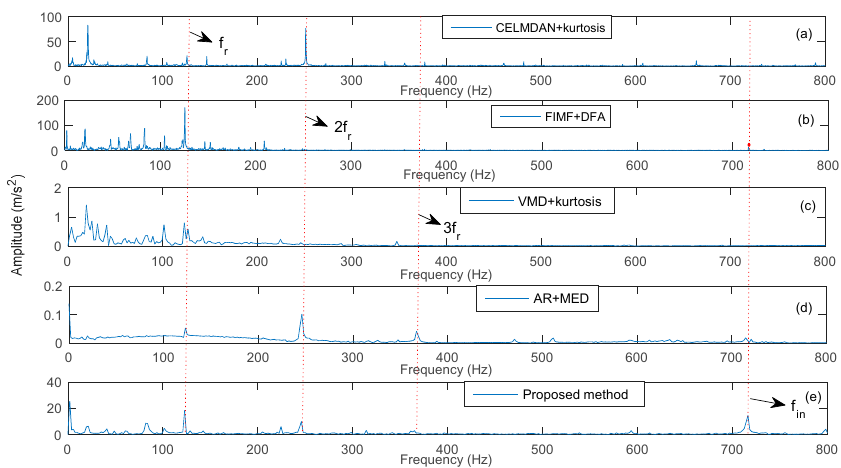
Figure 31. Identified fault frequency of a rolling bearing at 5000 RPM.